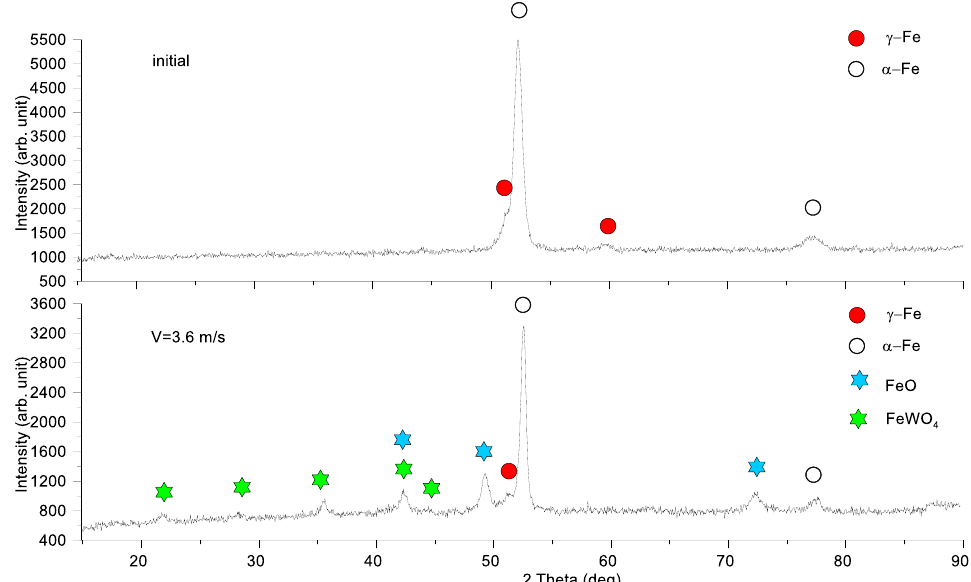
Materials 2023 , 16 , x FOR PEER REVIEW Figure 4. Glancing X-ray diffractograms of worn surfaces of M2/W coatings . Figure 4. Glancing X-ray diffractograms of worn surfaces of M2/W coatings. The worn surface of the AISI 52,100 counterbody after sliding at 3.6 m/s demon- strated the presence of both FeO and FeWO 4 along with the initially detected α - Fe and γ - Fe grains (Figure 5).